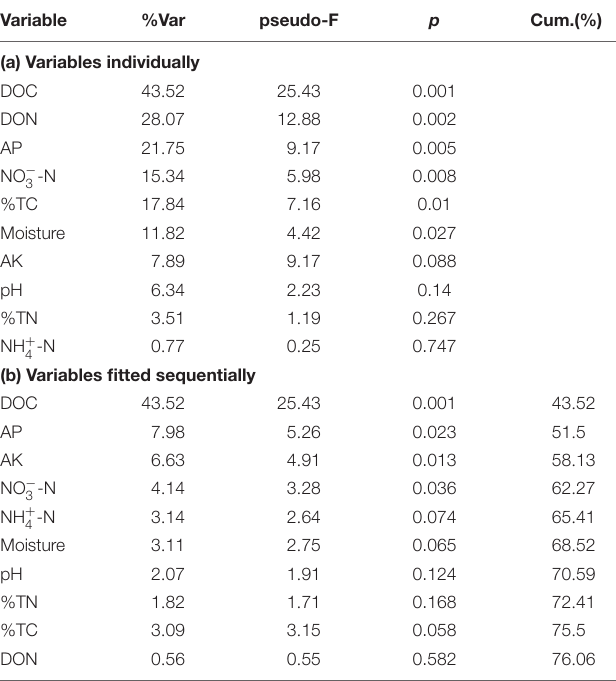
Var, percentage of variance in species data explained by that variable; Cum. %, cumulative percentage of variance explained. Variable abbreviations as in Table 2 . TC, total carbon; TN, total nitrogen; DOC, dissolved organic carbon; DON, dissolved organic nitrogen; NH + 4 -N, ammonium; NO − 3 -N, nitrate; AP, available P; AK, available K. (a) each variable analyzed individually (ignoring other variables); (b) forward-selection of variables, where amount explained by each variable added to model is conditional on variables already in the model.